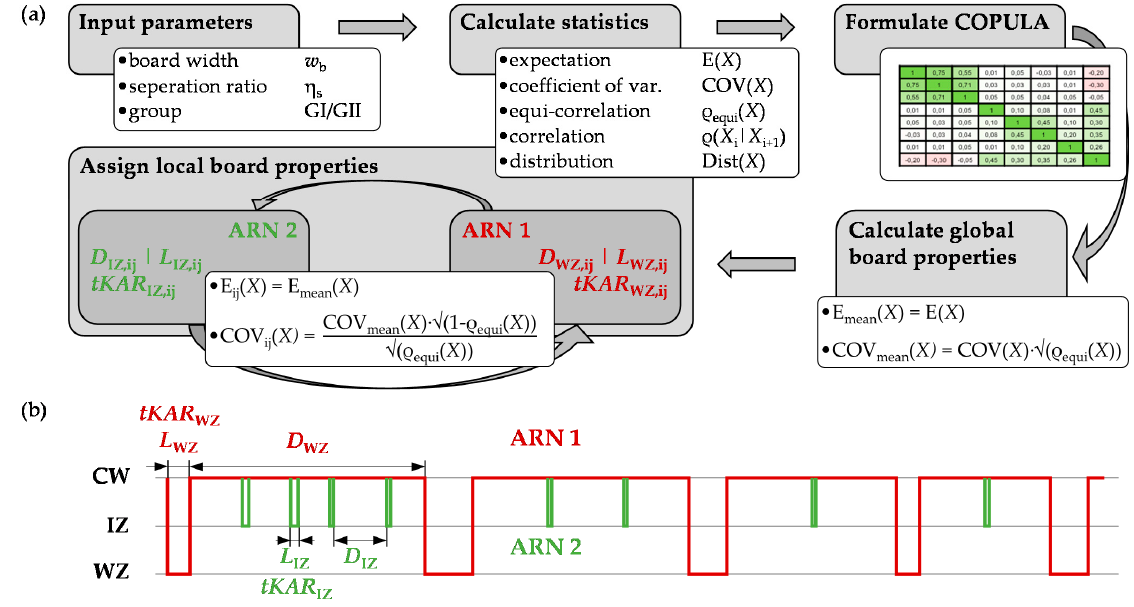
Figure 9. Board generation process ( a ) supported by two interlaced alternating renewal (AR) pro- cesses responsible for the assignment of local board properties ( b ).